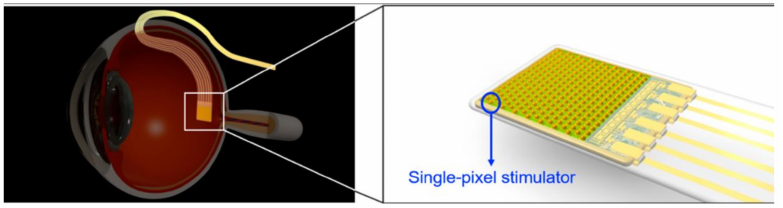
Figure 29. Subretinal prosthesis